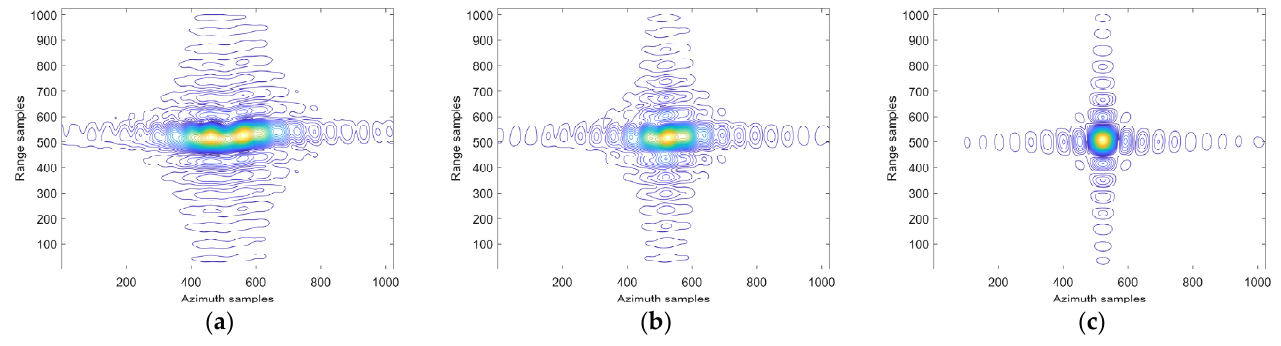
Figure 15. Contour plot of target P1 processed by di ff erent algorithms. ( a ) The conventional method; ( b ) The reference method; and ( c ) The proposed method.